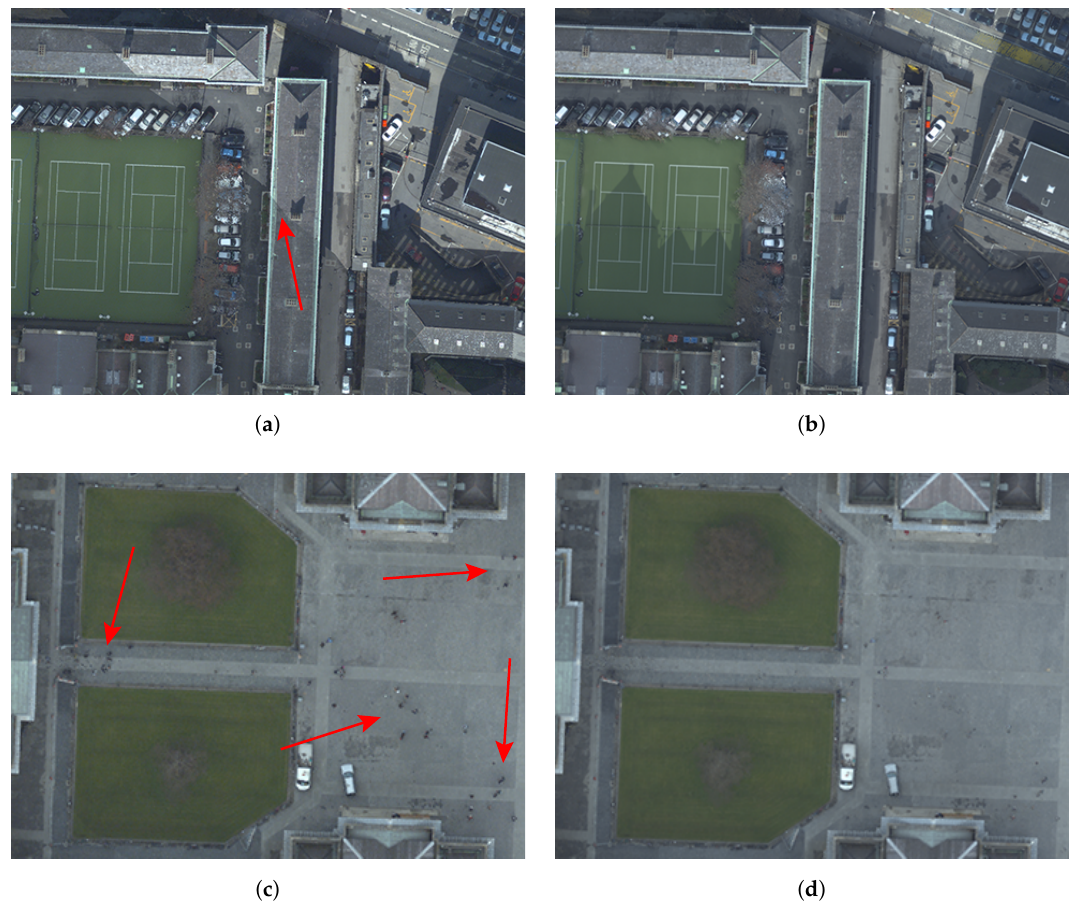
Figure 20. ( a , c ) Two parts of a true orthophoto generated using the closest visible image criteria, ( b , d ) true orthophotos produced using the IDW-based color balancing approach for the same areas shown in figures (a,c), respectively. Pixel size is equal to 10 cm in the